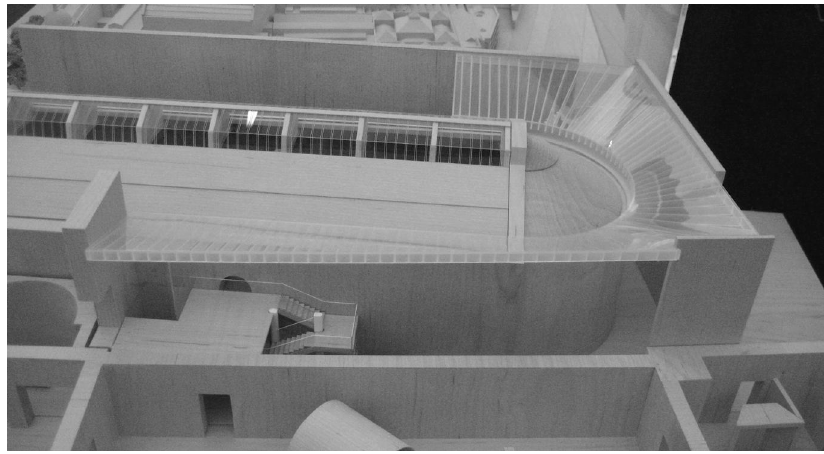
Figure 9: Model of glass roof Victoria & Albert